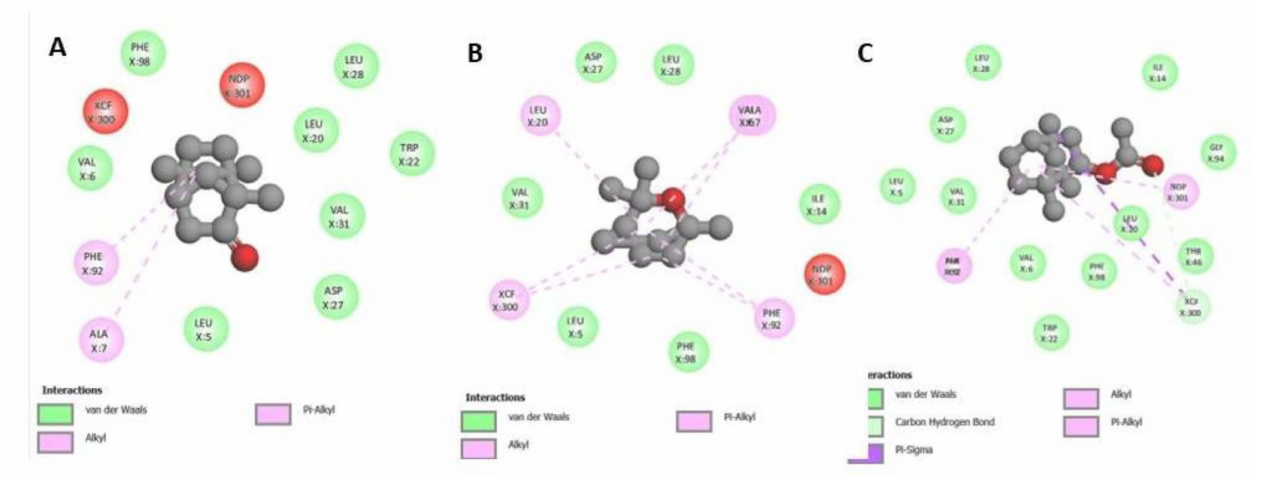
Figure 5. 2D scheme of DHFR interaction with the tested ligands ( A ) Eucalyptol; ( B ) Camphor; ( C ) Bornyl acetate.